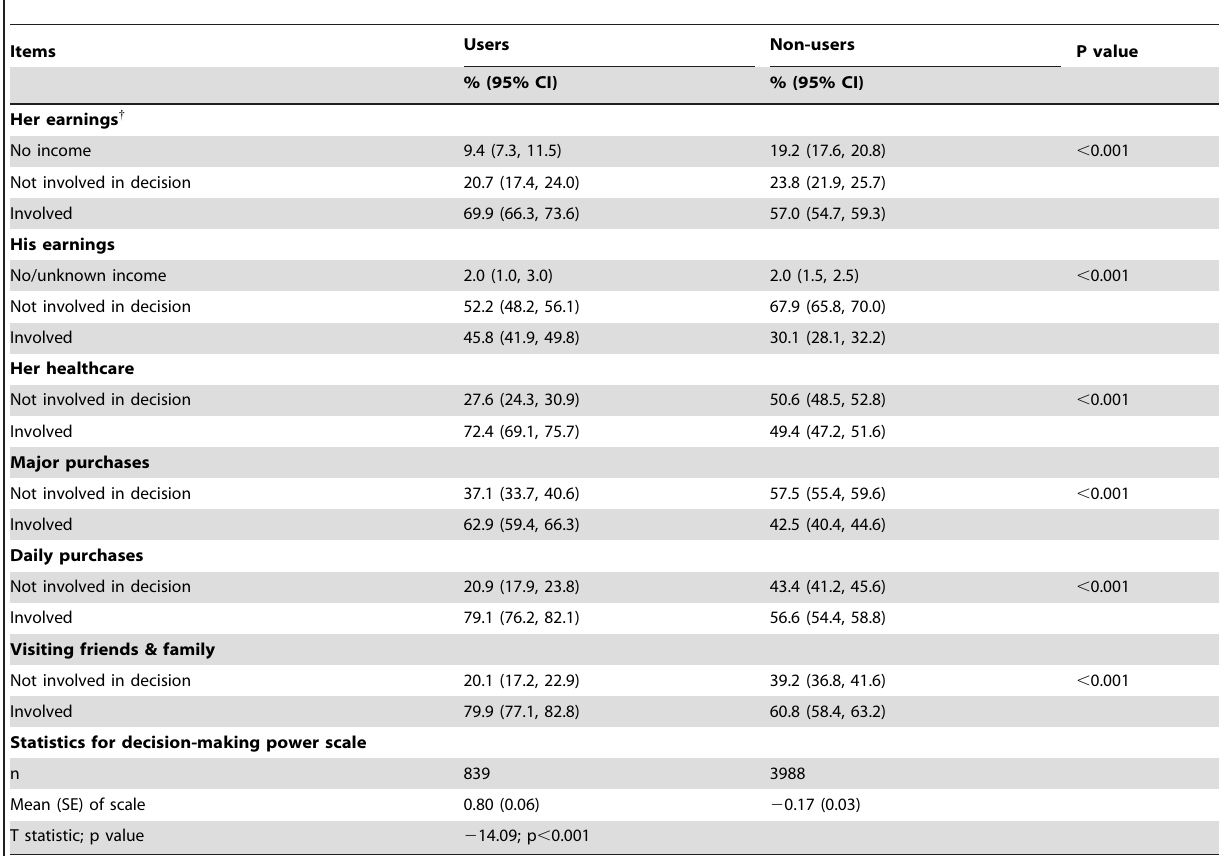
Table 2. Women’s Involvement in Household Decision-making by Current Modern Contraceptive Use